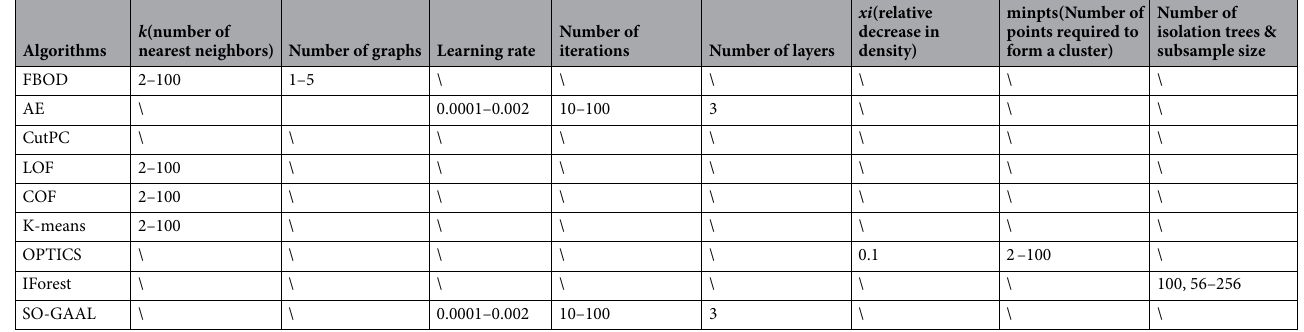
Table 3. Parameter